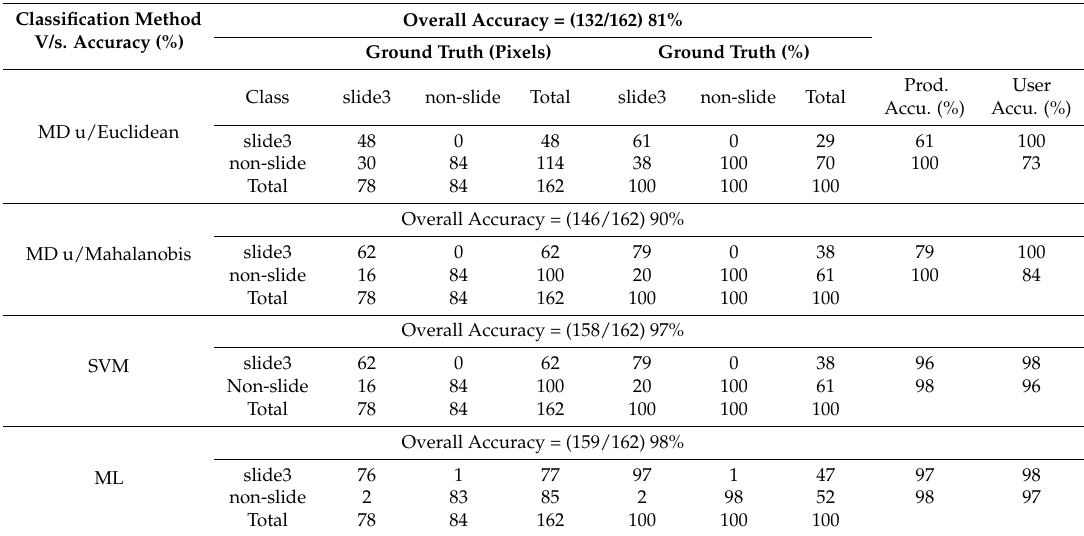
Table 3. Accuracy analysis of the MD using Euclidean and Mahalanobis distance, SVM, and ML classification, for the slide and non-slide areas.